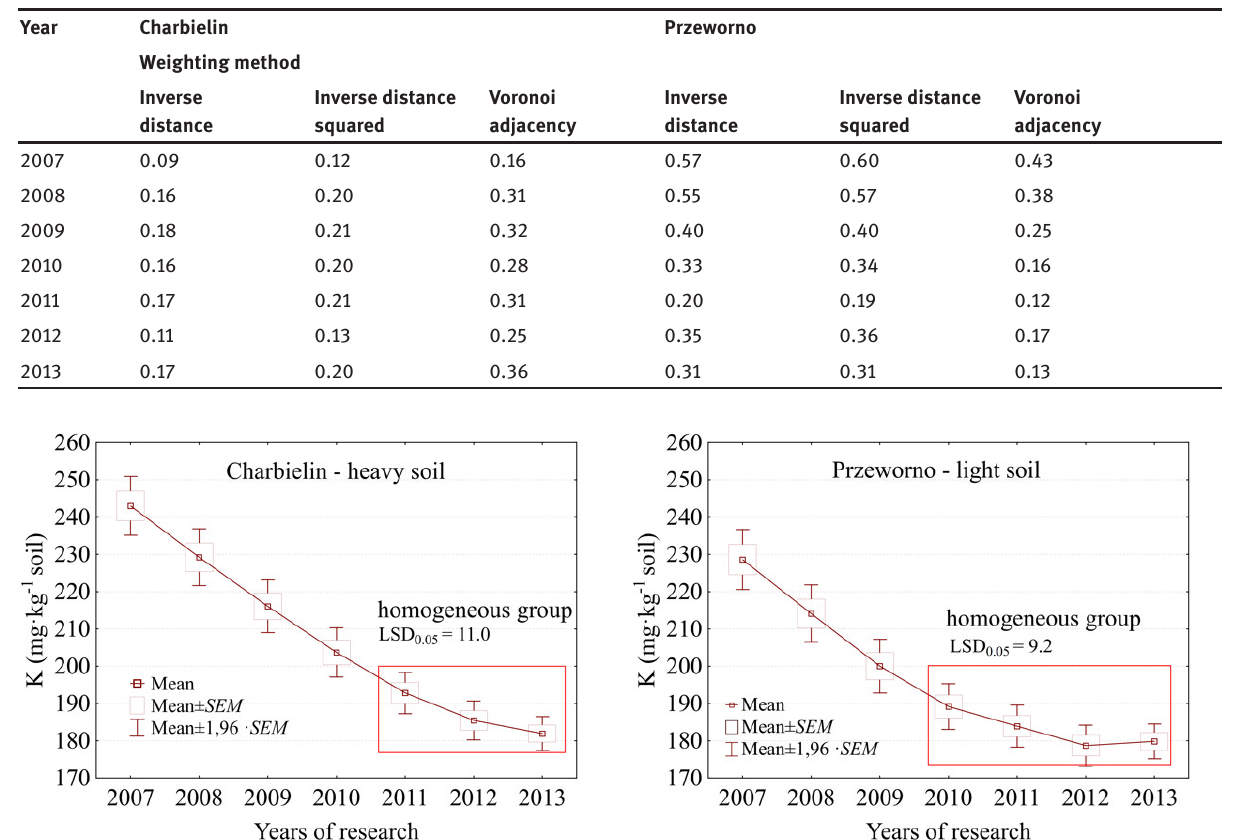
Figure 5: Analysis of the K soil levels in test F for the one-way ANOVA model.